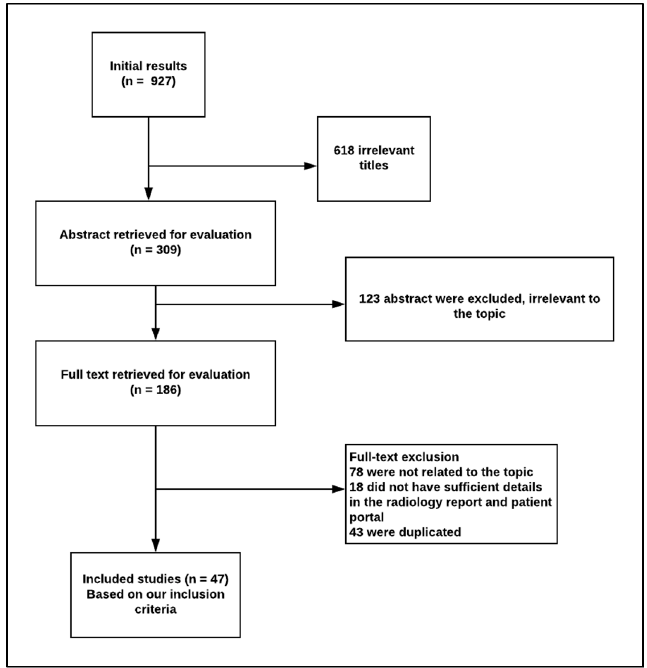
Figure 1. The criteria for inclusion and exclusion.